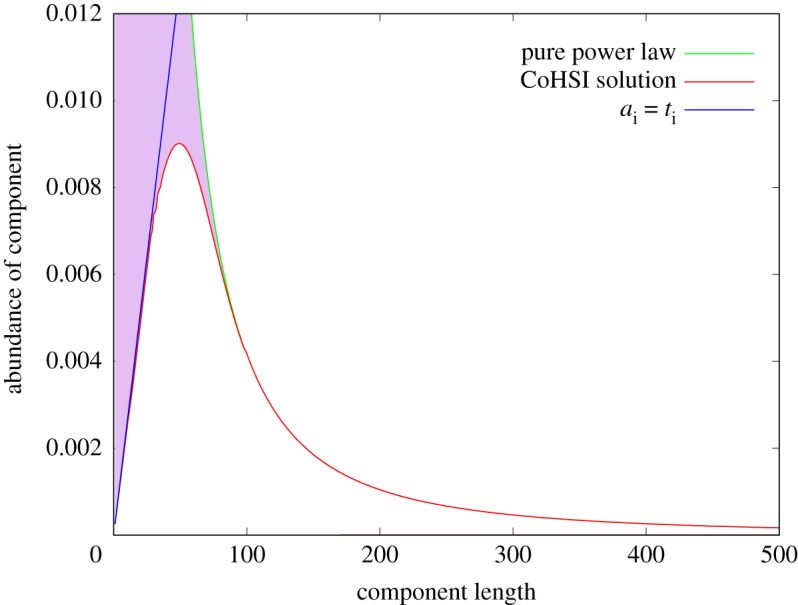
A close-up of figure 8 illustrating how the pure power law (green) is coincident with the full CoHSI solution (red) for component lengths above around 80 tokens but quickly departs from the full CoHSI solution for smaller components before abruptly reaching its peak value. The blue line indicates the natural boundary condition ti = ai, since manifestly no component can be smaller than its unique alphabet, which is of course enforced by the recursion. The purple region is the area between the pure power law and the full CoHSI solution.